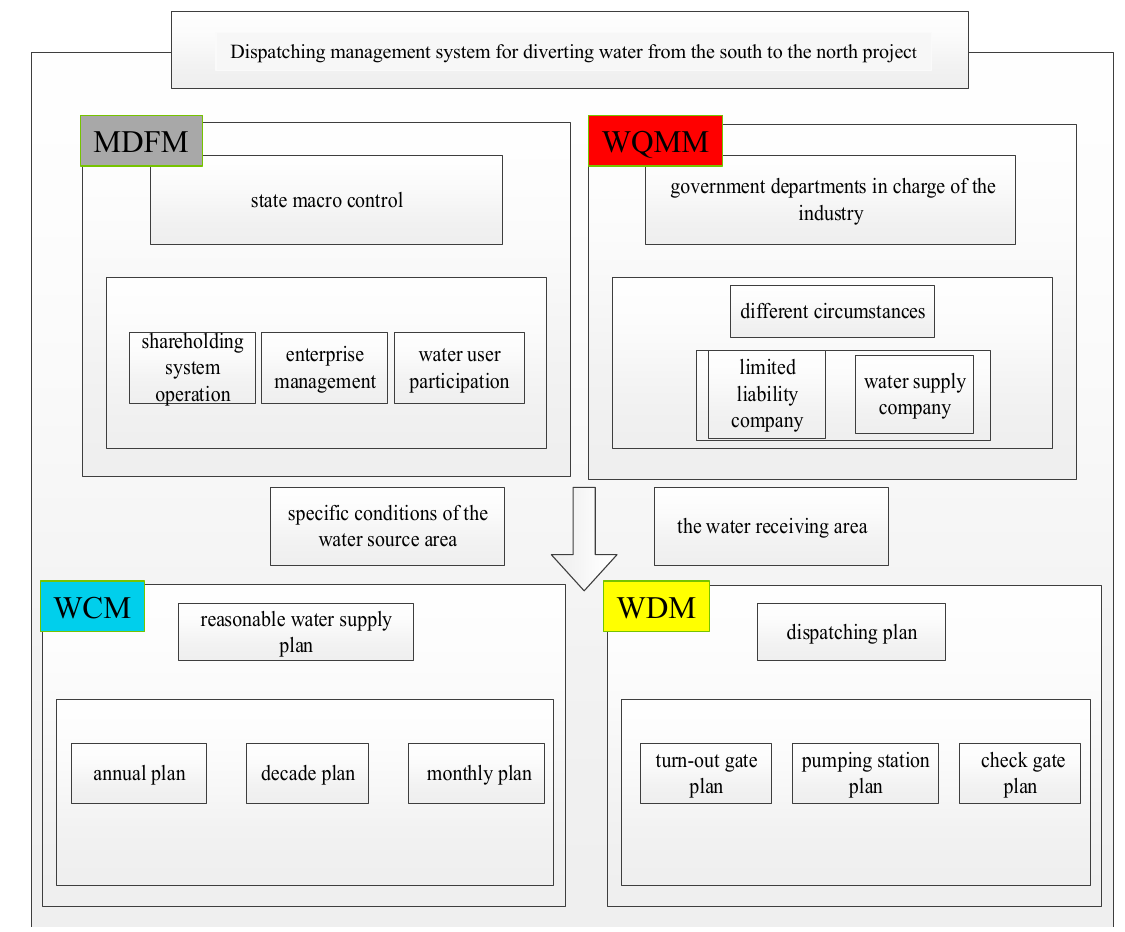
Figure 6. Framework of dispatching management systems for the SNWD. The four modules are shown in different colors (blue: WCM module; red: WQMM module; grey: MDFM module; yellow: WDM module).